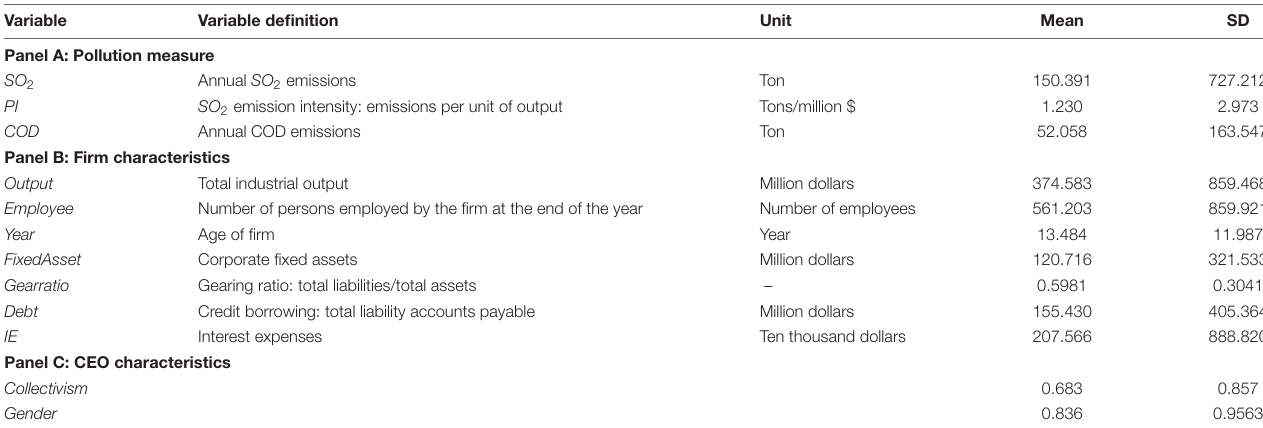
TABLE 2 | Definition of variables and descriptive